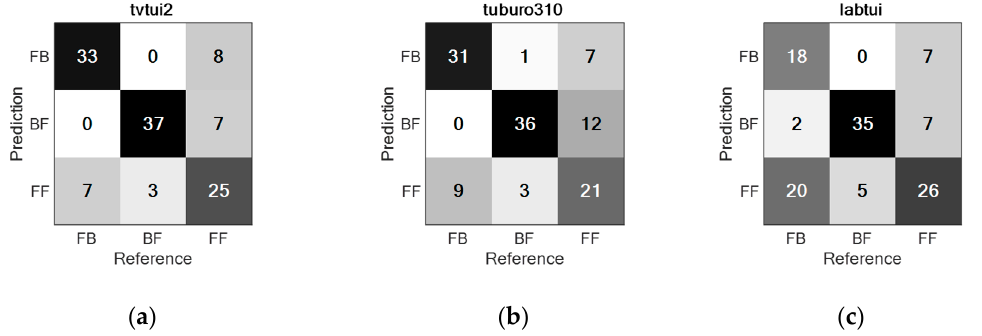
Figure4. Confusionmatricesobtainedforthebestthreemodelsinexperiment2: ( a )tvtui2; ( b )tuburo310; Figure 4 Confusion matrices obtained for the best three models in experiment 2: ( a ) tvtui2; ( b ) and ( c ) tuburo310; and ( c ) labtui.